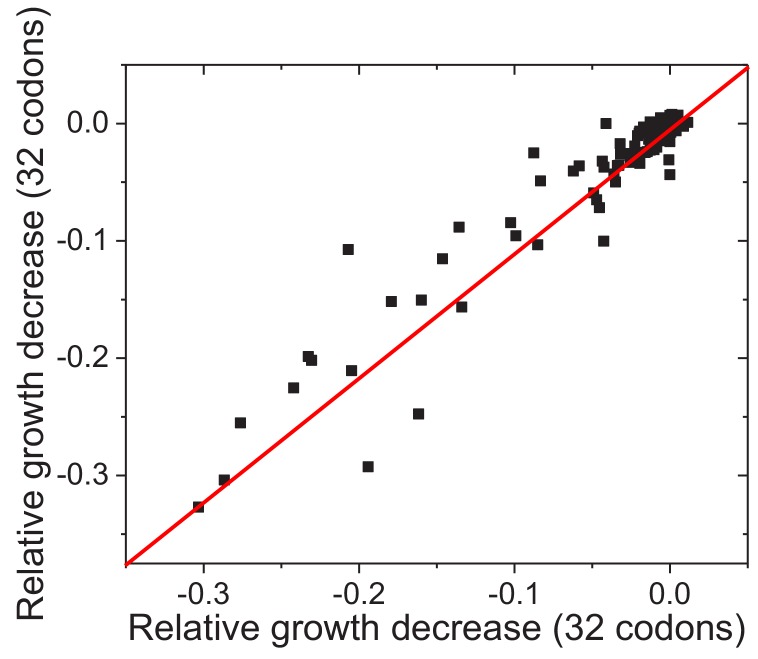
Reproducibility of experimentally measured average fitness effects of amino acid substitutions across FolA sites.The similarity between the average fitness effects of substitutions across FolA sites was calculated using two non-overlapping sets of substitutions (see Materials and methods). Each dot in the figure represents one FolA site. The relative growth decrease in the X axis was calculated based on the relative growth rates of mutants carrying 32 randomly selected codons; the relative growth decrease in the Y axis was calculated based on the relative growth rates of mutants carrying the remaining 32 codons. The line X = Y is shown in red. Pearson’s r = 0.95, p-value<1e-20.